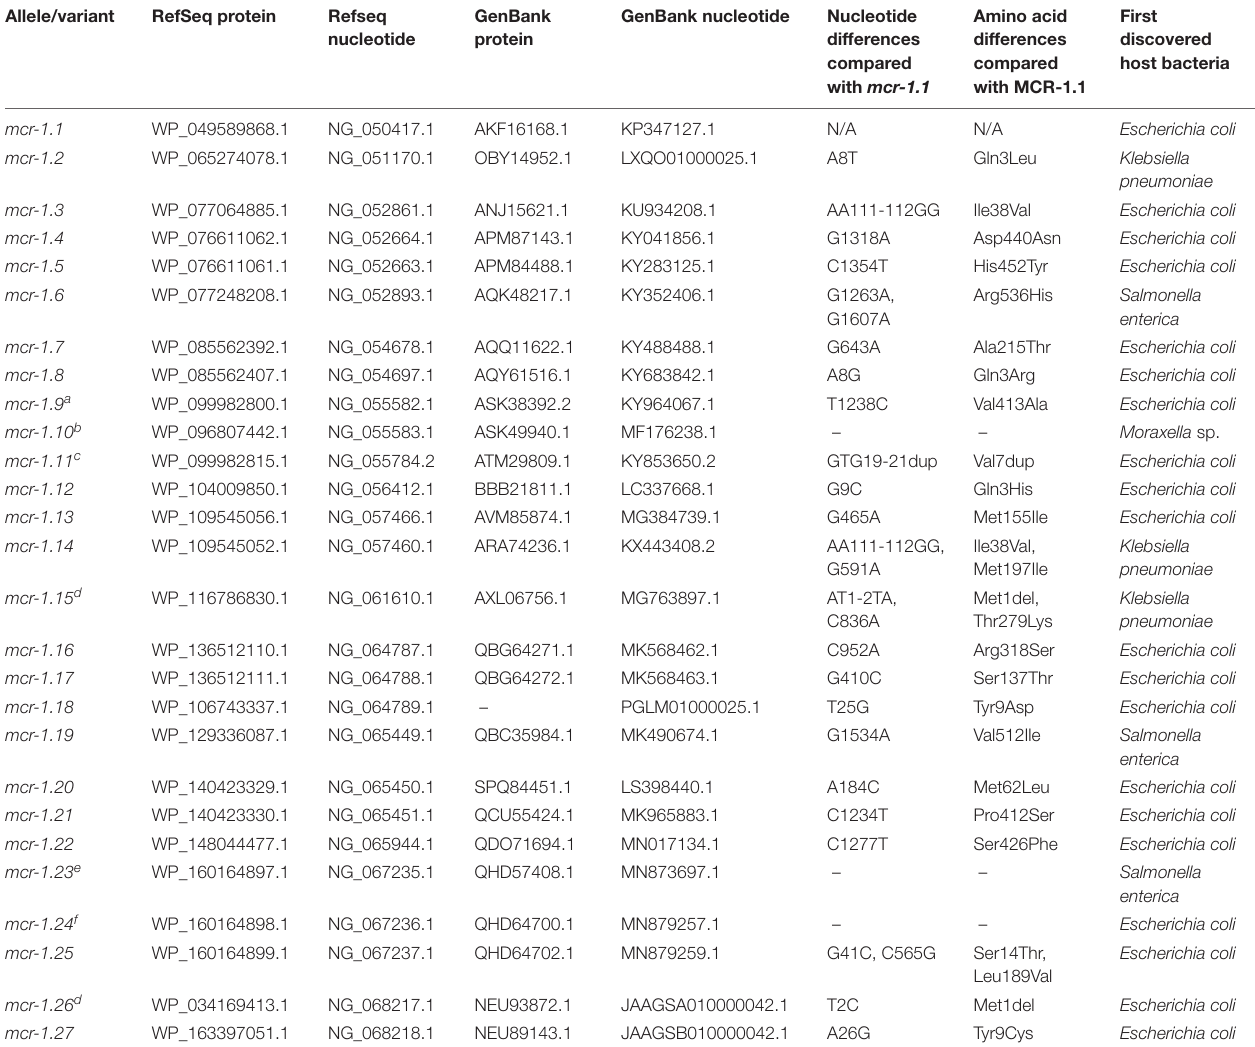
TABLE 5 | Nucleotide/amino acid changes of mcr-1 /MCR-1 alleles/variants compared with mcr-1.1 /MCR-1.1 (the accession numbers emanated from Reference gene browser with gene family “ mcr-1 ,” database version: 2020–05-04.1. Nucleotide and amino acid differences were identified by Geneious software). Allele/variant RefSeq protein Refseq